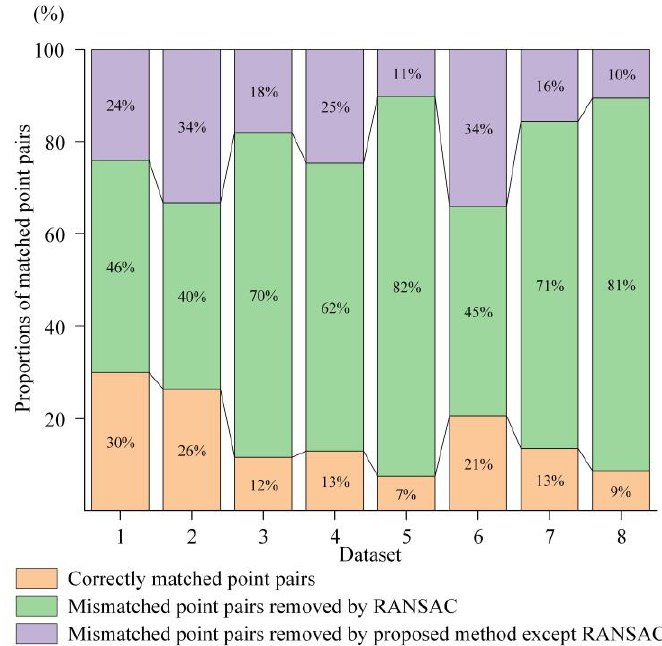
Figure 5. Proportions of matched point pairs in the UAV image used by the proposed method.